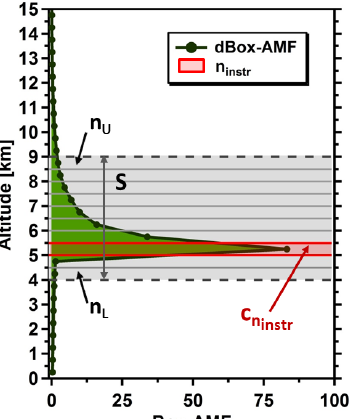
Figure 1. dBox-AMF values modeled at 477nm on a 0.5km grid (grey lines within S) for an EA 0 ◦ dSCD measurement at 5.25km and a zenith reference from 7.75km, with a solar zenith angle of 10 ◦ . Grey shading indicates the sensitive range S demarcated by the lower and upper limit layers n L and n U . Green shading emphasizes the strong sensitivity of the EA 0 ◦ measurement at instrument alti- tude, while the red box marks the instrument layer n instr for which the trace gas concentration c n is being instr